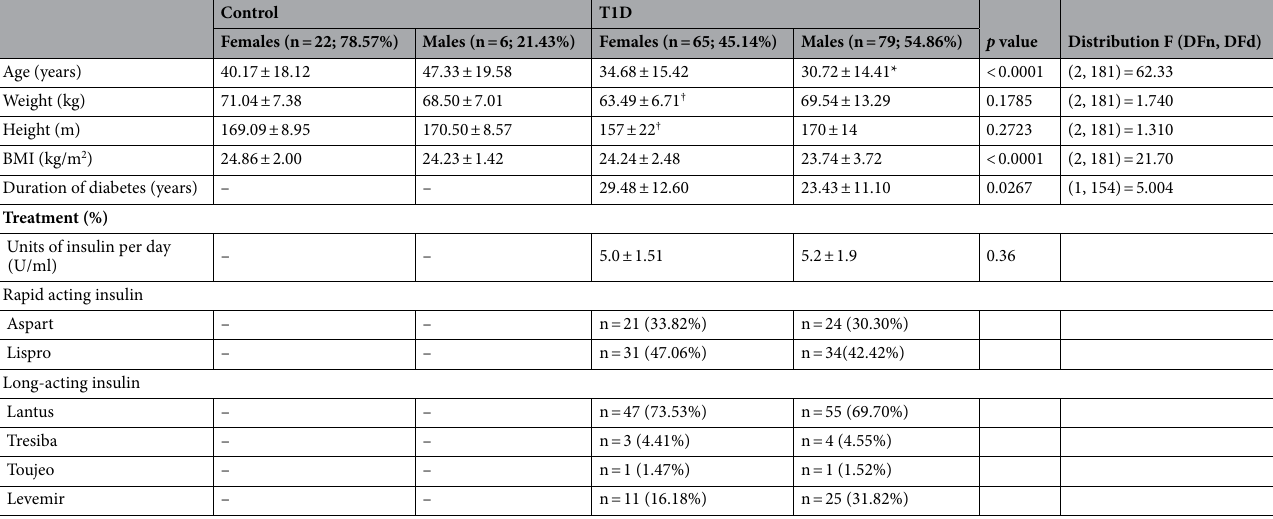
Table 1. Baseline characteristics of subjects with T1D and control groups, with subgroups of females and males. Data are showed as mean ± standard deviation (SD). SD of glucose: standard deviation of glucose. %CV for glucose: percentage coefficient of 2 variation for glucose. Two ways ANOVA, following Holm-Sidak post hoc. Units of insulin per day (mean ± SD). * p < 0.005, Males T1D versus Males Control. † p < 0.005, Females T1D versus Females